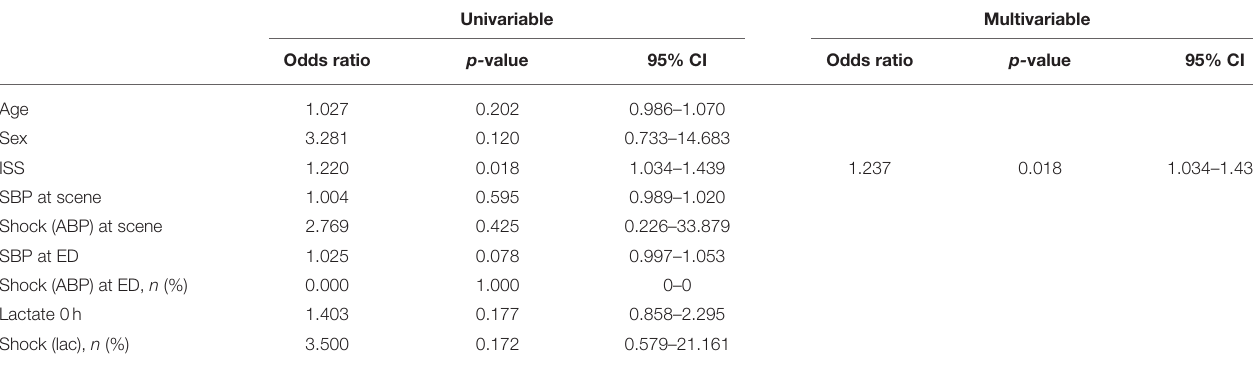
TABLE 3 | Results of logistic regression analyses of variables predicting the development of disseminated intravascular coagulation in patients with isolated traumatic brain injury. Univariable